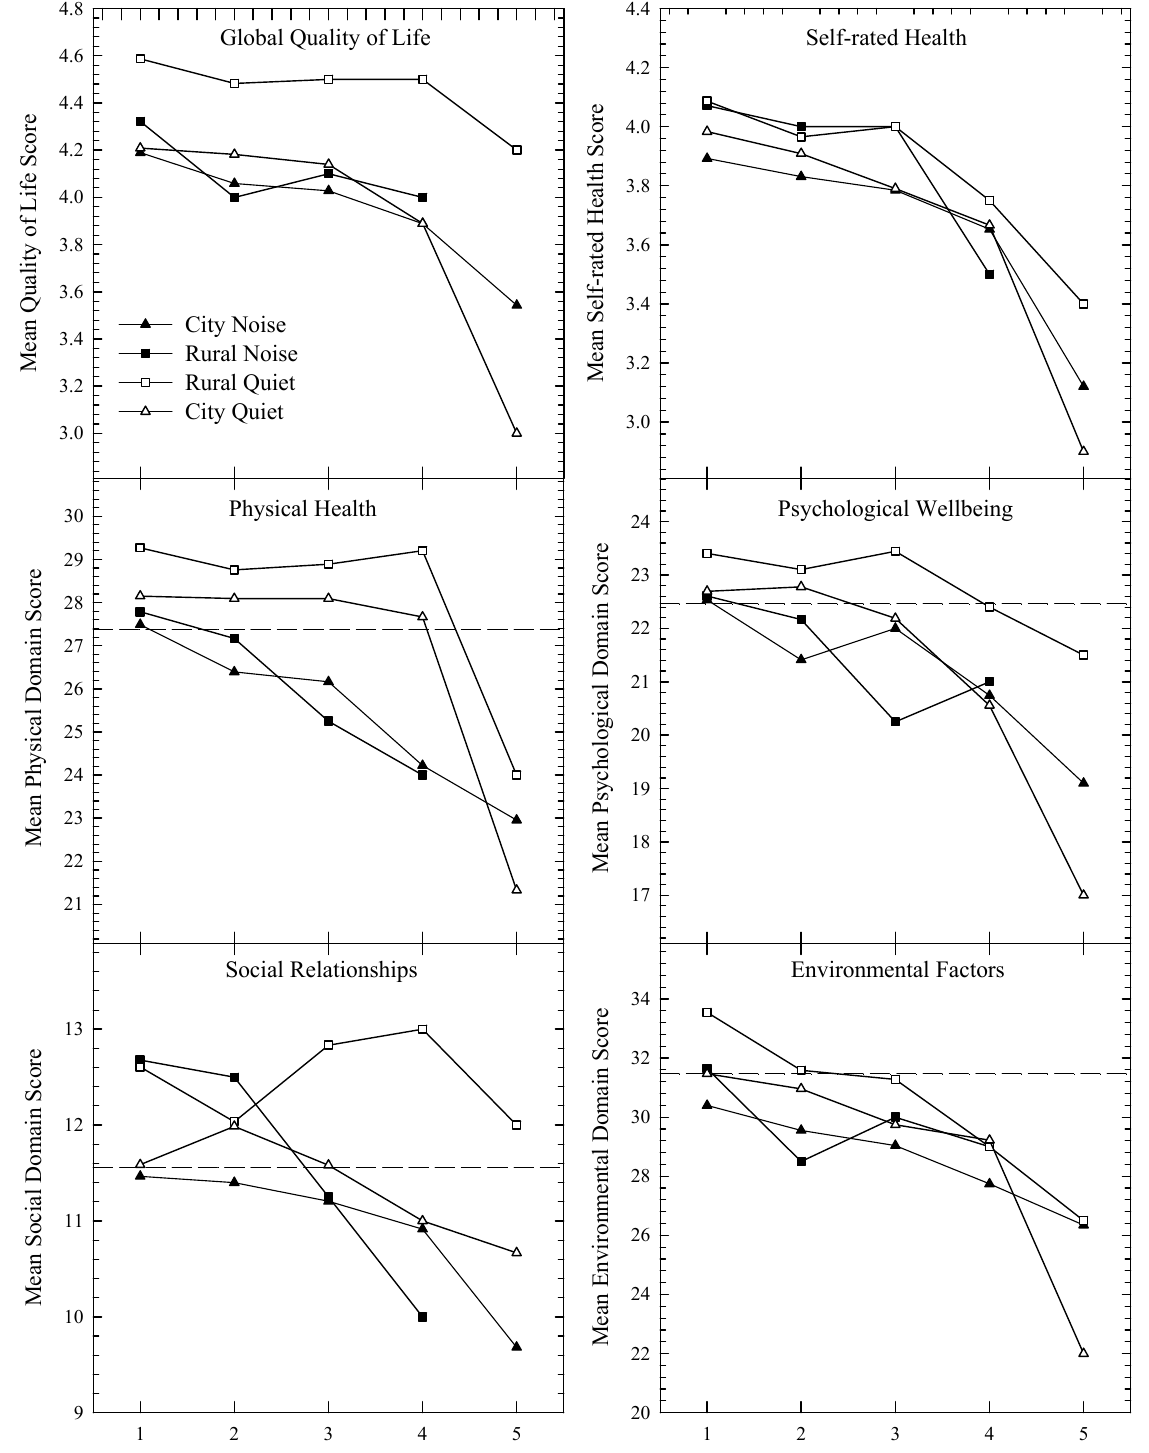
Figure 2. WHOQOL-BREF measures as a function of annoyance to transport noise for the four areas. Note too that the rural noisy area functions plot only four points, as only one individual rated their annoyance as “5”. The dashed-horizontal lines contained within the plots of the four WHOQOL-BREF domains represent national means calculated from a normative